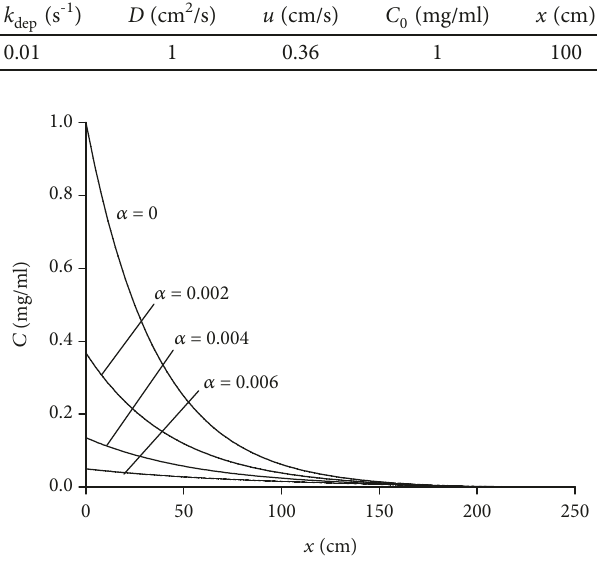
Figure 8: Relationship between particle concentration and distance for four decay factors, using parameters given in Table 7. Table 7: Model parameters for simulations shown in Figure